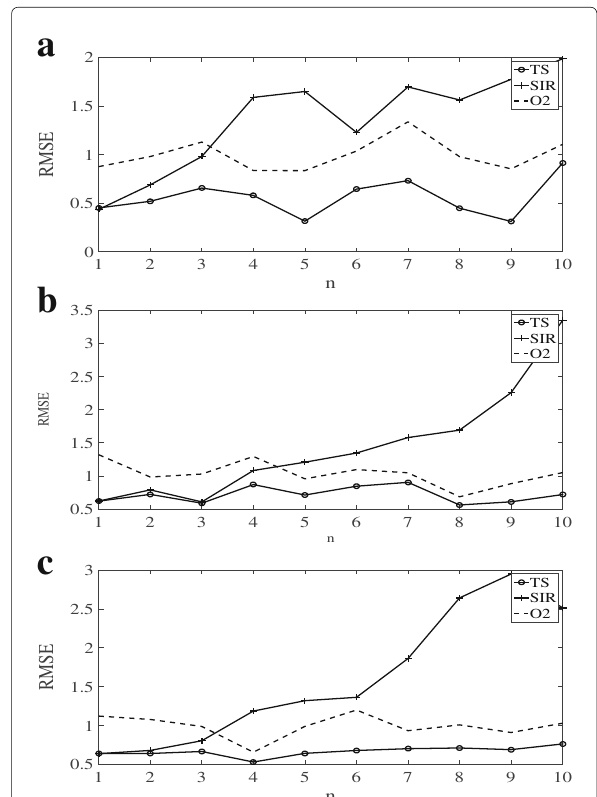
Fig. 6 An illustration of the traceplots of average RMSE over N = 100 experiments for the TS, SIR, O 2 procedures based on ( Q , R ) = ( 0.5,1 ) : a x n ,1 , b x n ,2 , and c x n ,3